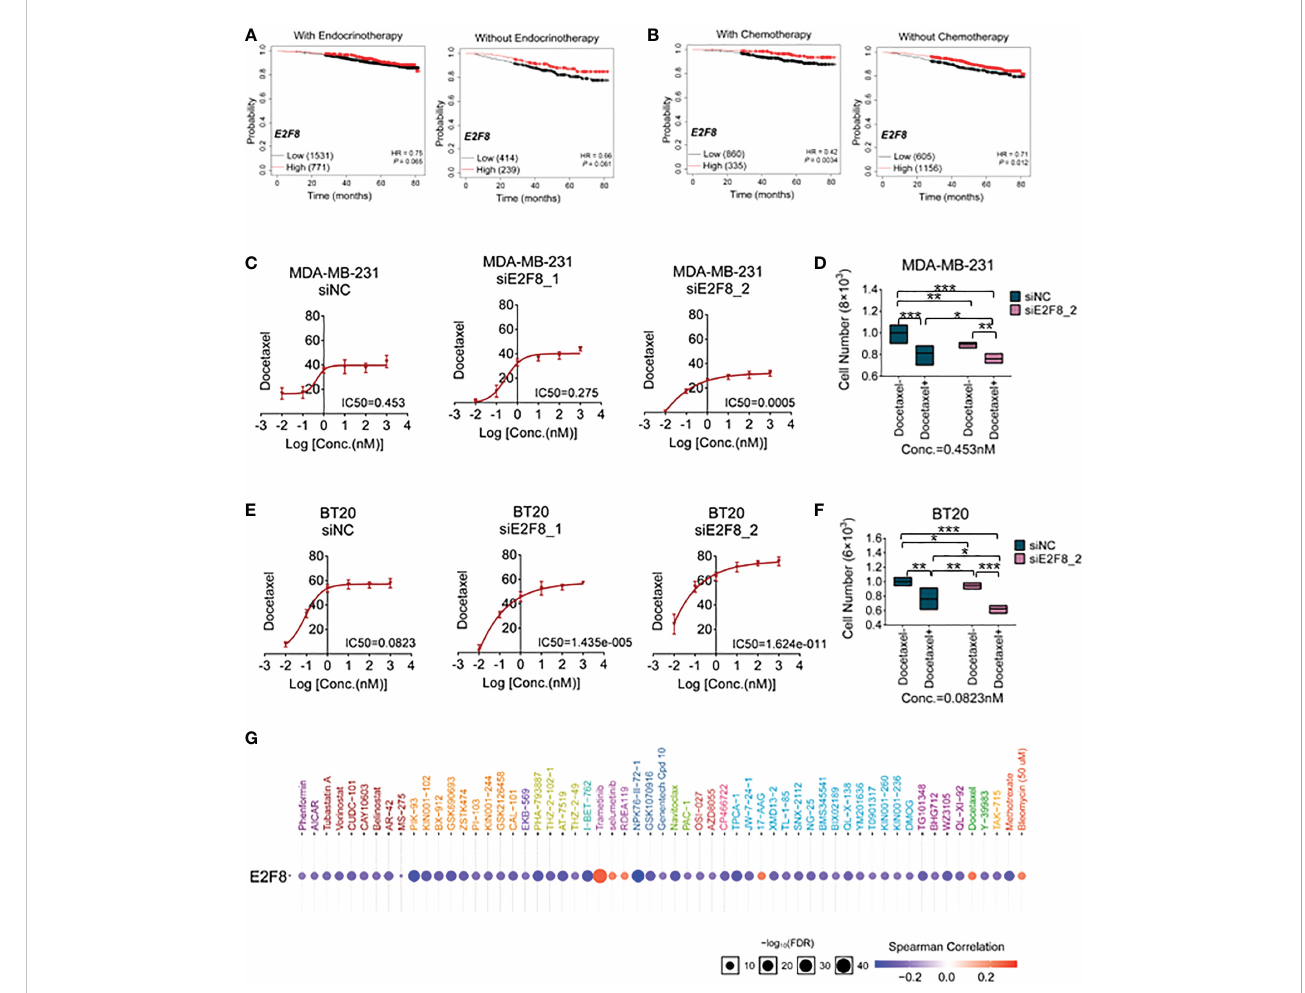
FIGURE 6 The treatment for breast cancer patients with high expression of E2F8. (A) Kaplan – Meier survival analyses of the overall survival (OS) of patients suffering from invasive breast cancer. The OS groupings covered patients “ with ” or “ without ” endocrinotherapy who had “ high ” or “ low ” expression of E2F8. (B) The OS groupings covered patients “ with ” or “ without ” chemotherapy who had “ high ” or “ low ” expression of E2F8 or MYBL2. CCK-8 analysis of the IC 50 of cells treated with docetaxel for the siNC group, siE2F8 1 group, and siE2F8 2 group in (C) MDA-MB-231 cell and (E) BT20 cell lines. CCK-8 analysis of the drug susceptibility for the siNC group, siNC with the docetaxel-treated group, the siE2F8 group, and siE2F8 with the docetaxel-treated group in (D) MDA-MB-231 and (F) BT20 cell lines. (G) Targeted drugs in anti-E2F8 in breast cancers by the GSCALite online database. The sensitive drugs were represented by the blue color, while the resistant drugs were represented by the red color. *P<0.05, **P<0.01 and ***P<0.001 compared with control